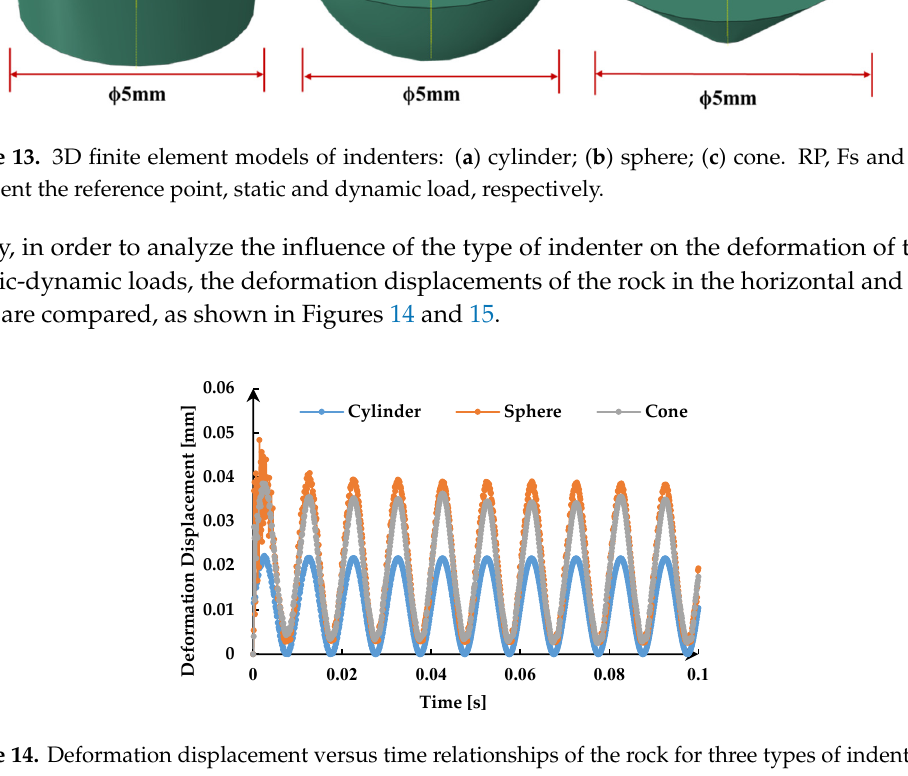
Figure 14. Deformation displacement versus time relationships of the rock for three types of indenters under static-dynamic loads.